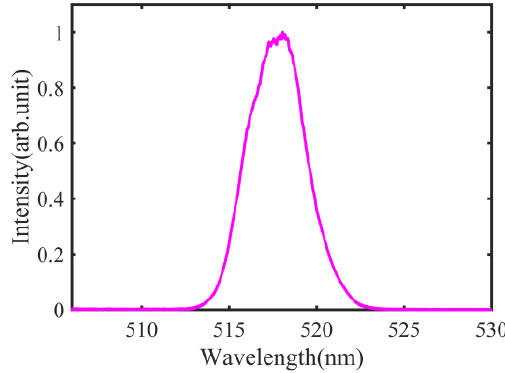
Figure 2. The source spectrum.